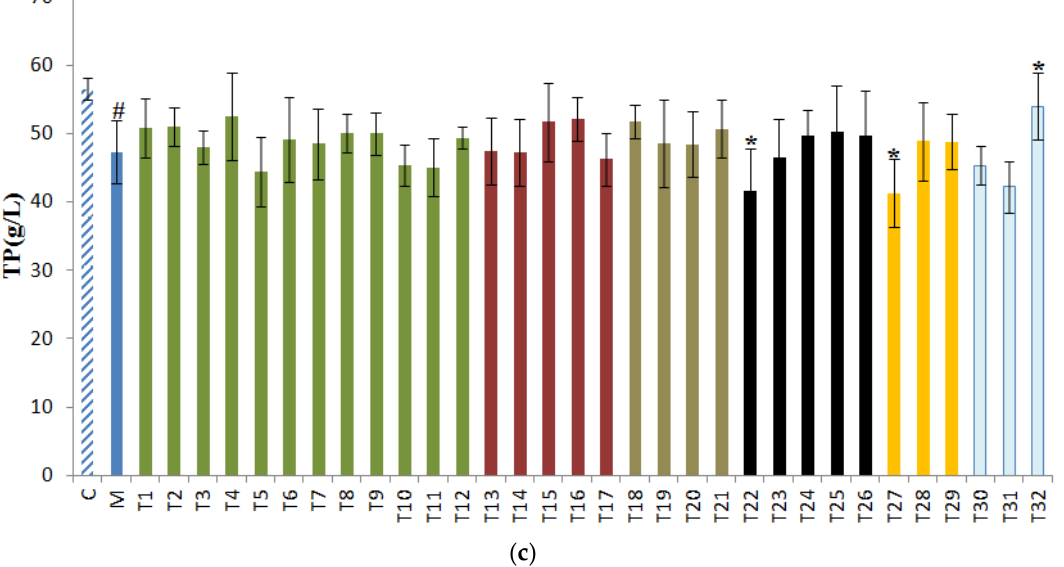
Figure 2. The e ff ects of 32 teas on serum ( a ) triacylglycerol (TG); ( b ) total bilirubin (TBIL); ( c ) total protein (TP) levels. # p < 0.05, the model group versus the control group. * p < 0.05, the treatment group versus the model group. C, the control group; M, the model group; T1, Chaoqing Green Tea; T2,